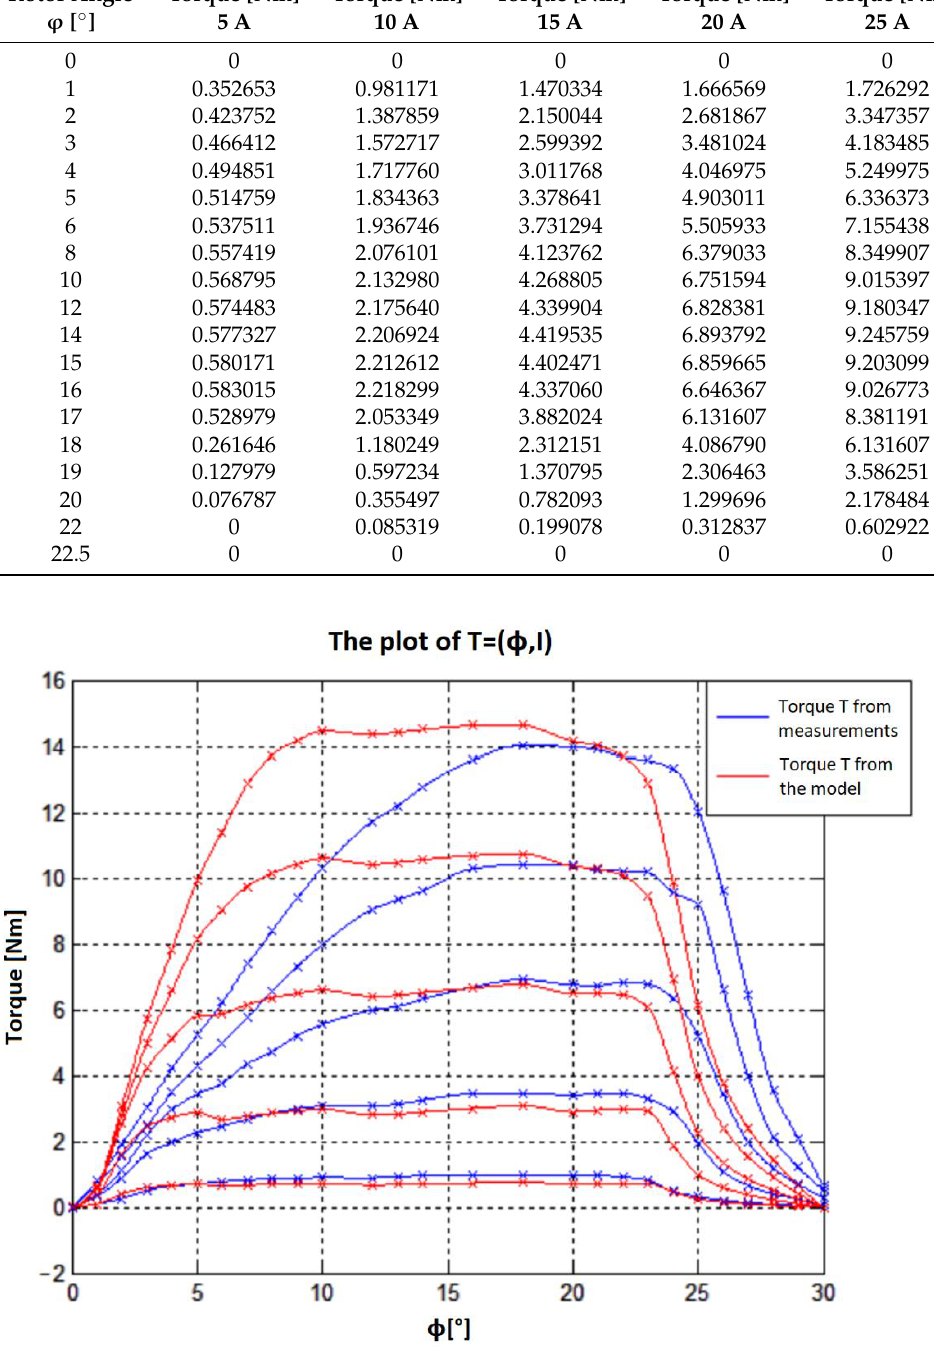
Figure 23. An 8/6 motor: juxtaposition of the torque characteristics between those from the model and those from laboratory measurements.